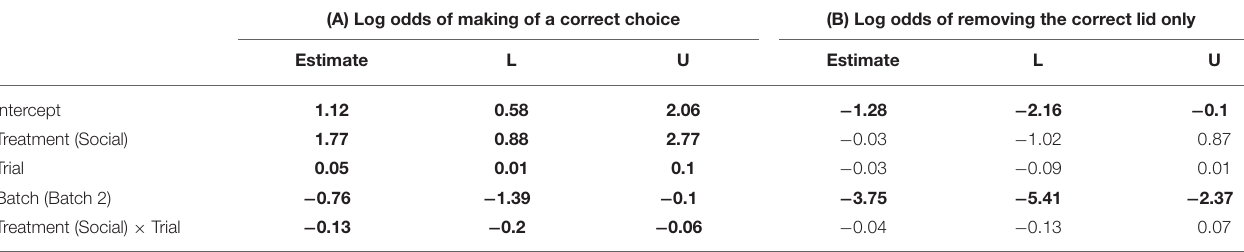
TABLE 3 | Pooled posterior modes and 95% credible intervals from a Bayesian Markov chain Monte Carlo generalized linear mixed effects model (GLMM) examining the effects of (A) a lizard’s treatment group (social learning or control), batch (1 or 2), and trial number on the log odds of making a correct choice, and (B) the log odds of choosing the correct dish only (N lizards = 28, N obs =